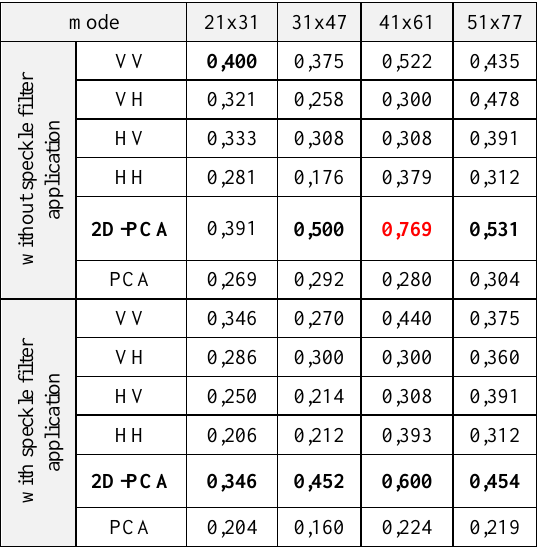
Table 1 FoM calculation for RadarSAT-2